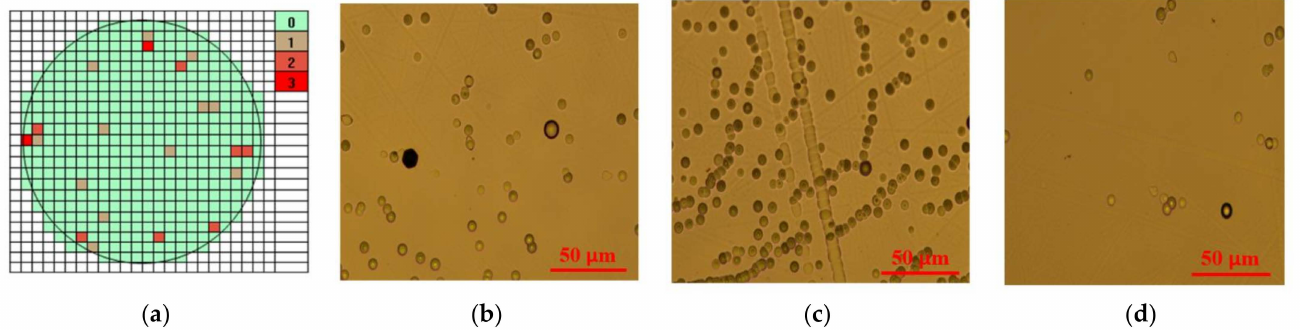
Figure 9. Micropipe maps of 4H-SiC wafers for SiC:N (10 vol%) ( a ) and defects at the Si face of 4H-SiC revealed after etching in molten KOH ( b – d